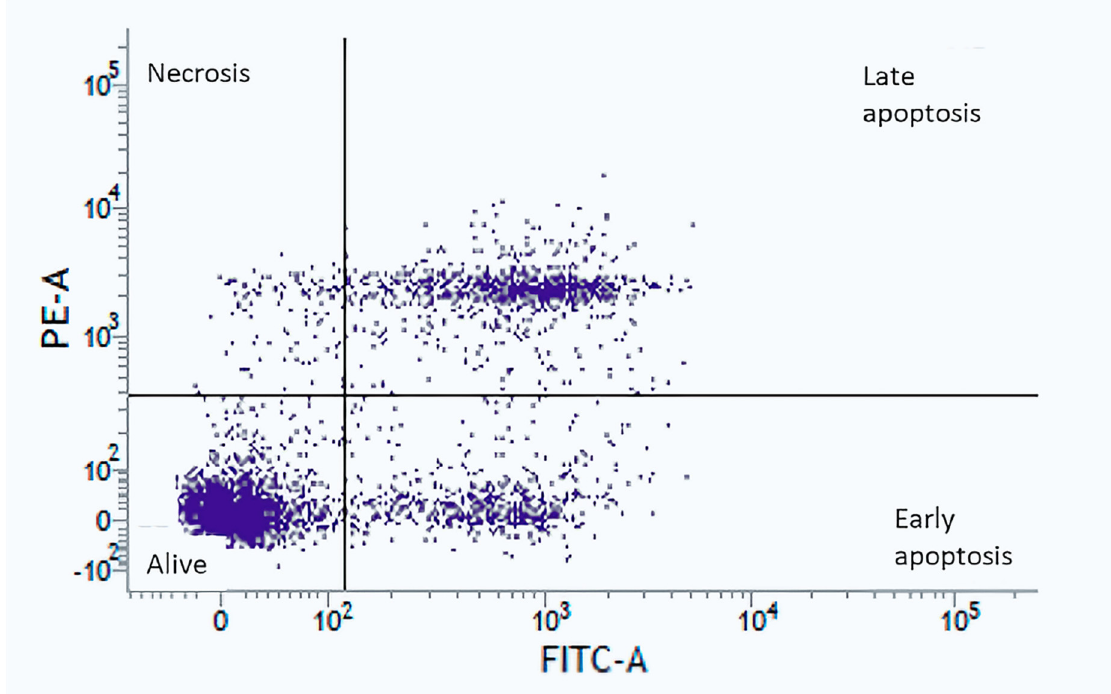
Figure 6. Apoptosis and cell death determination using Annexin V and propidium iodide (PI) staining. Nasal epithelial cells were selected based on morphology. Apoptosis status was determined by Annexin V staining. Cell death was determined by PI staining. Gating methods for Annexin V − /PI − (live), Annexin V+/PI − (early apoptosis), Annexin V − /PI+ (necrosis), and Annexin V+/PI+ (late apoptosis) are shown.